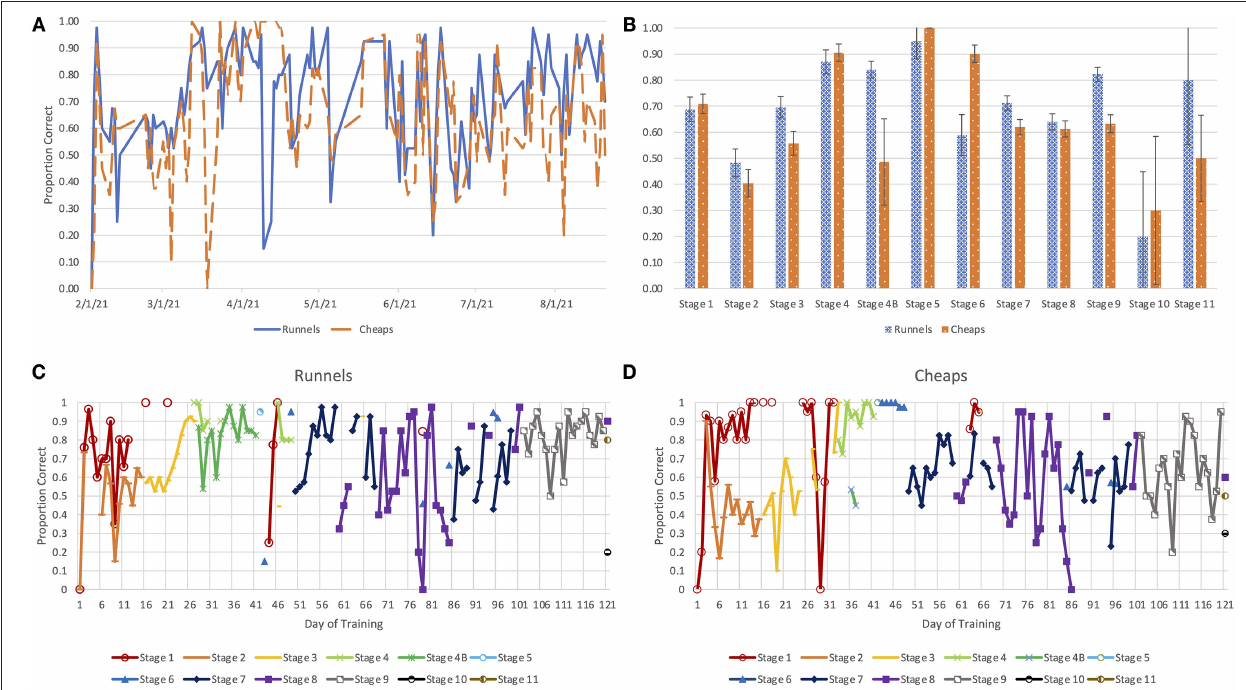
FIGURE 2 | The proportion of correct responses observed (A) throughout the training process and (B) for each stage of training. Learning curves for Runnels (C) and Cheaps (D) , illustrating the proportion of correct responses for each stage of training, separated by session, although the number of trials of each stage per session